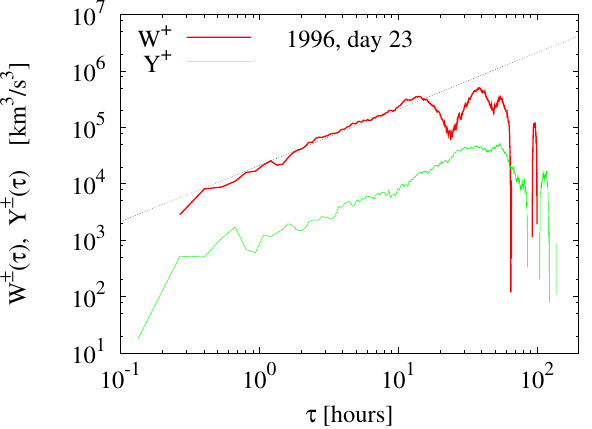
Figure 93: The linear scaling relation is reported for both the usual third-order structure function 𝑌 + and the same quantity build up with the density-mediated variables 𝑊 + clearly observed. Data refer to the Ulysses spacecraft. Image reproduced by permission from Carbone et al. (2009a), copyright by